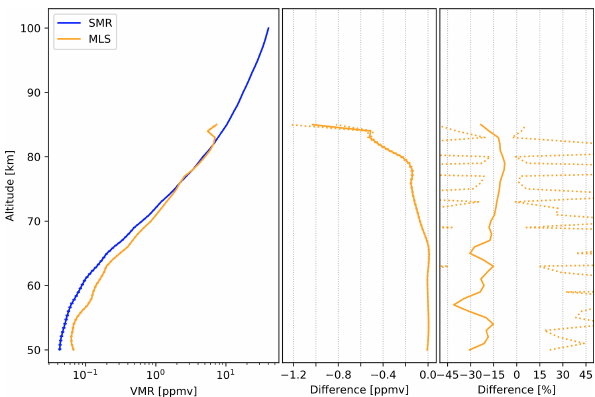
Figure 11. Comparison of SMR CO concentrations with the ones from MLS observations. The data plotted are global averages over the whole time between July 2004 and March 2019. Panels charac- teristics are the same as in Fig. 9.